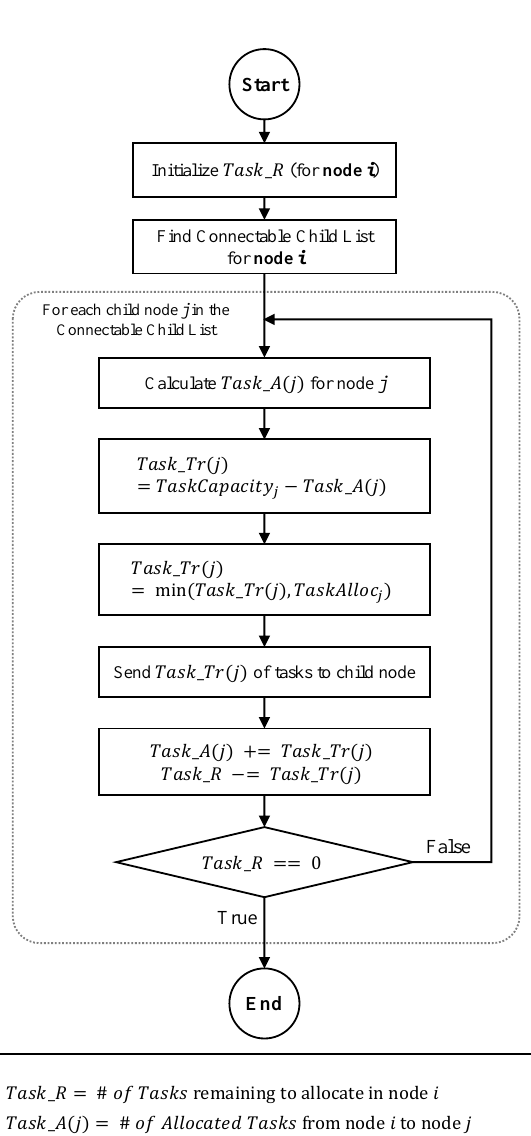
Figure 6. Flowchart of task distribution